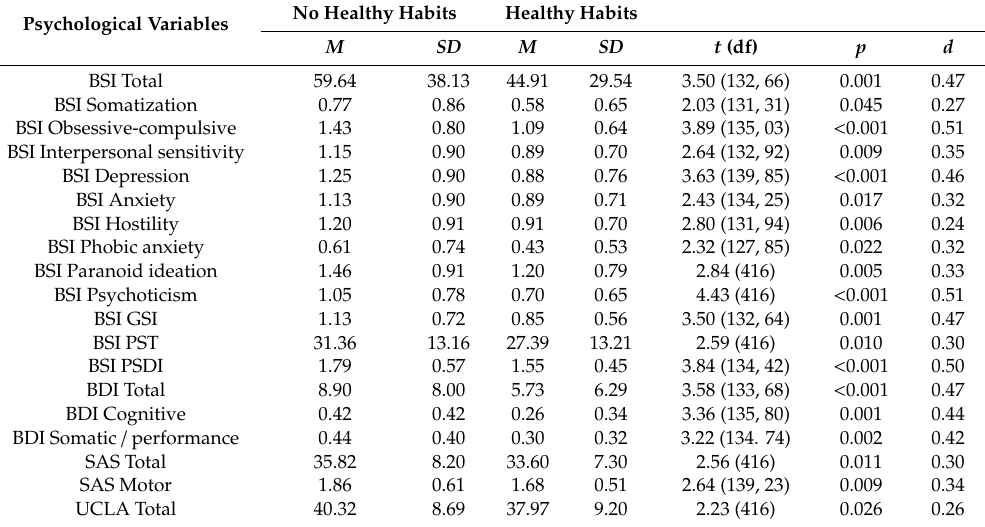
Table 10. Significant means di ff erences of healthy eating